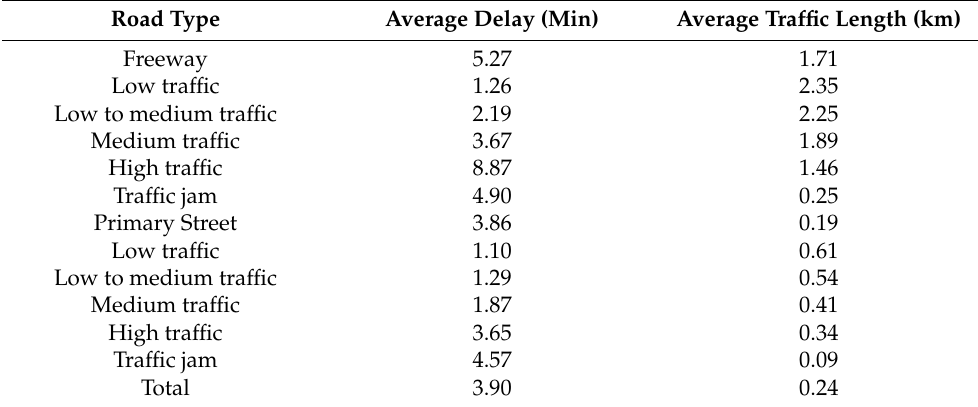
Table 14. Average delay and traffic length by road